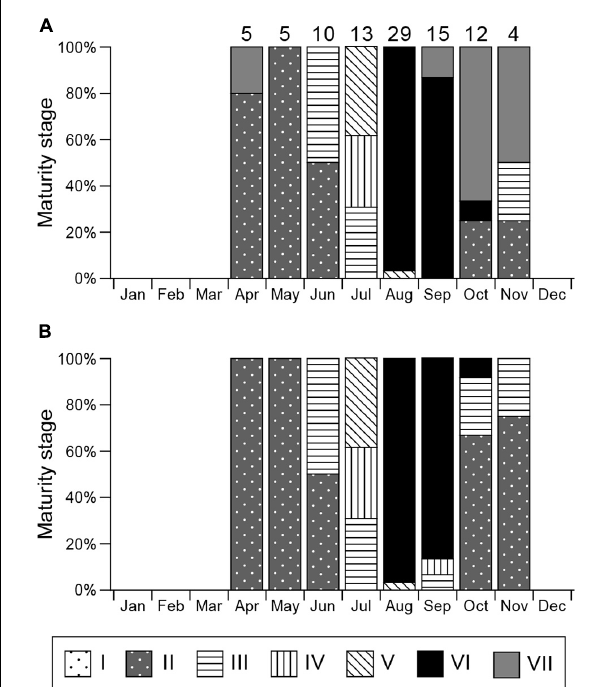
FIGURE 5 | Monthly gonadal maturity stages for mature male Aetobatus narutobiei . (A) Considering the most mature stage and (B) most mature stage disregarding the degenerate zone. Sample size for each month is indicated above the bar.